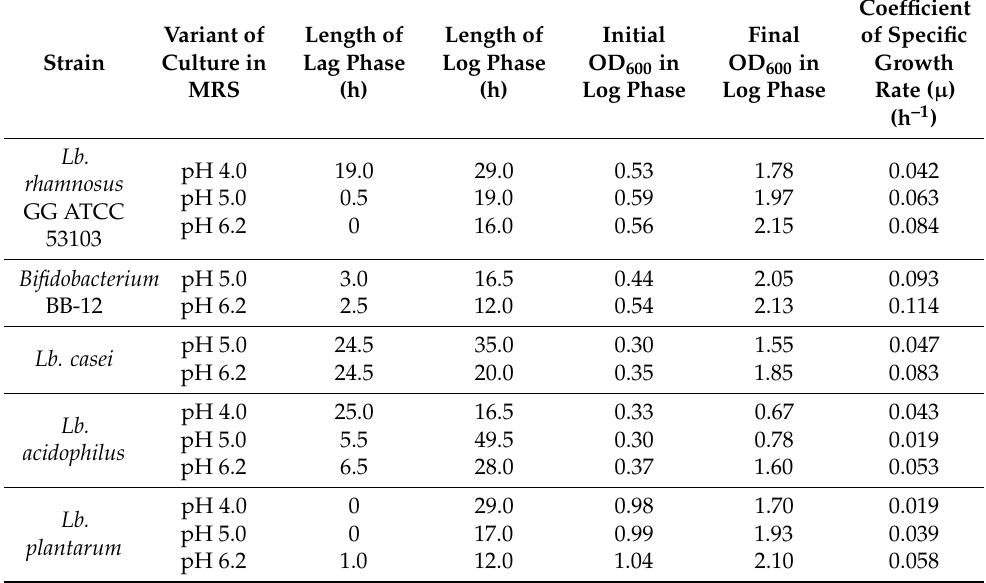
Table 2. Selected lag and log phase lengths, initial and final OD 600 in log phase, and coefficient of spe- cific growth rate for the bacteria present in commercial probiotic preparations tested in MRS